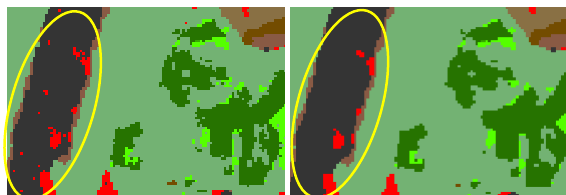
Figure 8. Example of majority filter work. Changes indicted within yellow